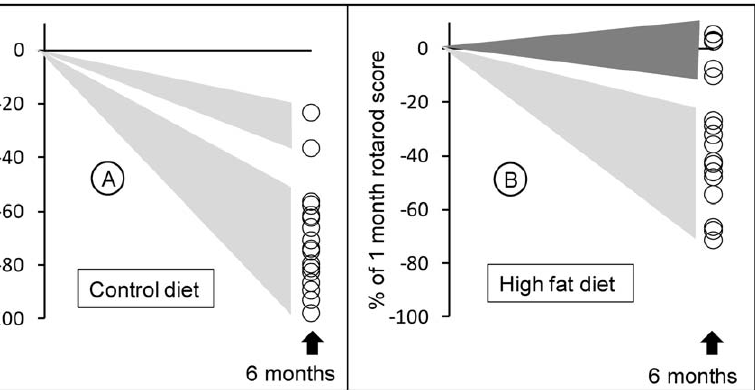
Figure 5. Percentage of individual loss or gain on the rotarod at 6 months of age relative to 1 month of age in Harlequin mice on control (A) or high fat diet (B). Note the presence of a subset of 6 HFD-Harlequin-responder individuals (dark grey).